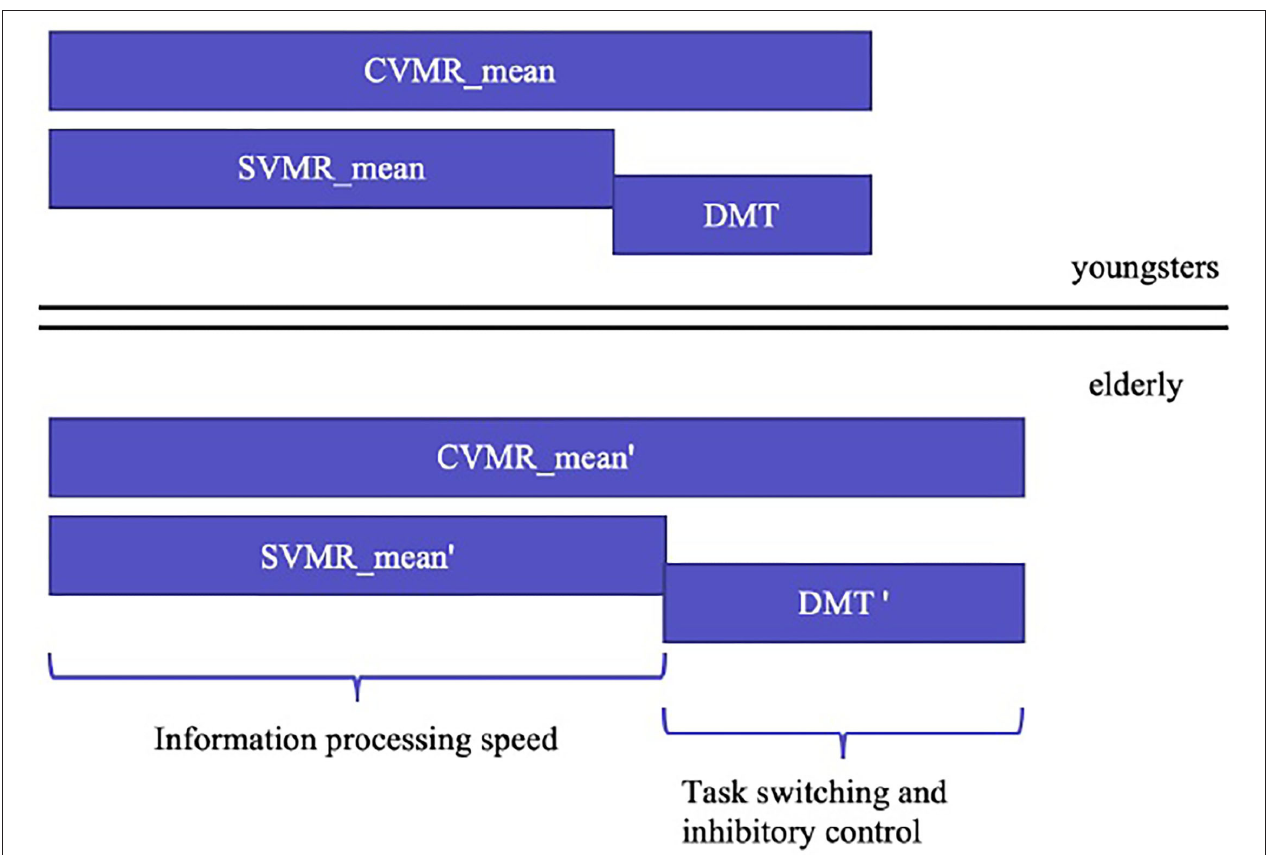
FIGURE 4 | Age-related changes in simple and complex visual-motor tasks estimates and the cognitive functions they